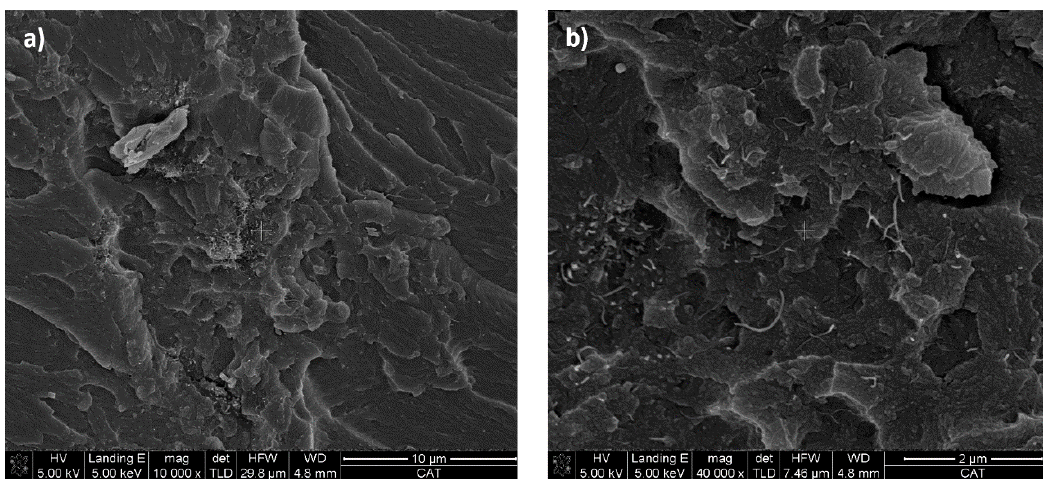
Figure 5. FEG-SEM micrographs showing CNTs distribution of the 0.100 wt % CNT specimen at ( a ) low magnifications and ( b ) high magnifications.